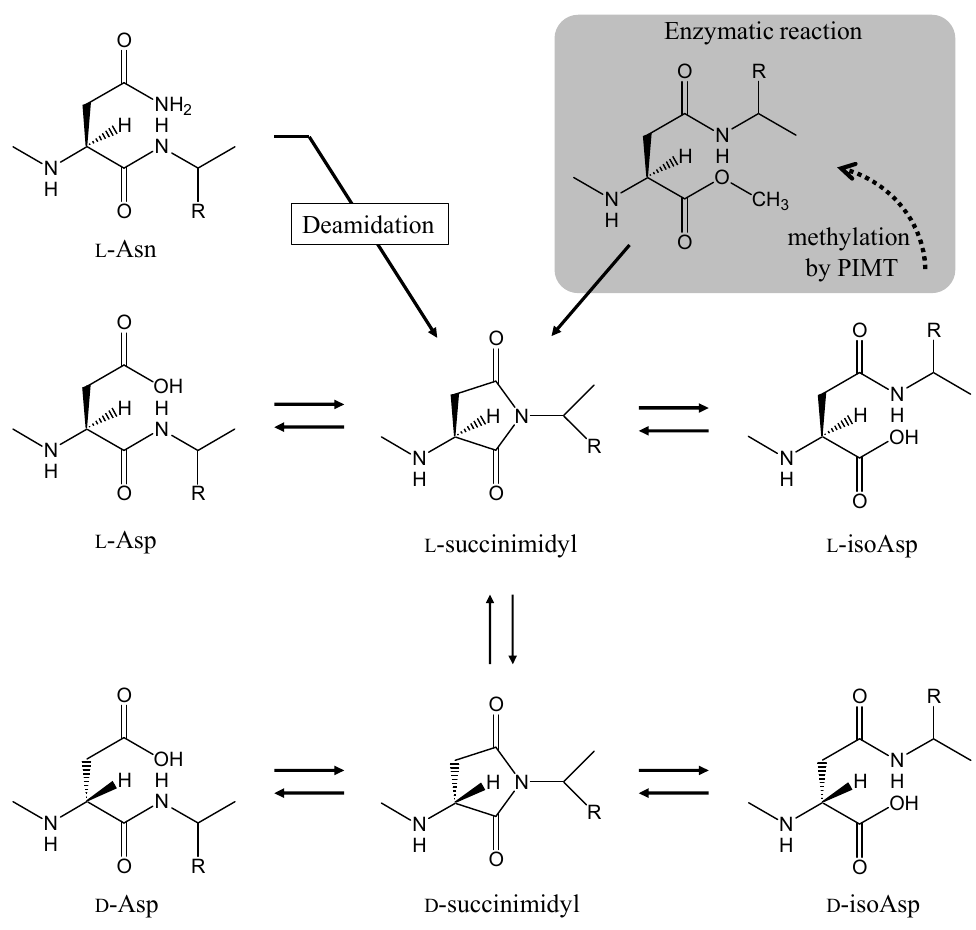
Figure 2. Pathways for spontaneous deamidation, isomerization, and racemization of L -Asn and L -Asp residues in the proteins. The PIMT repair system for L -isoAsp residue is also shown.